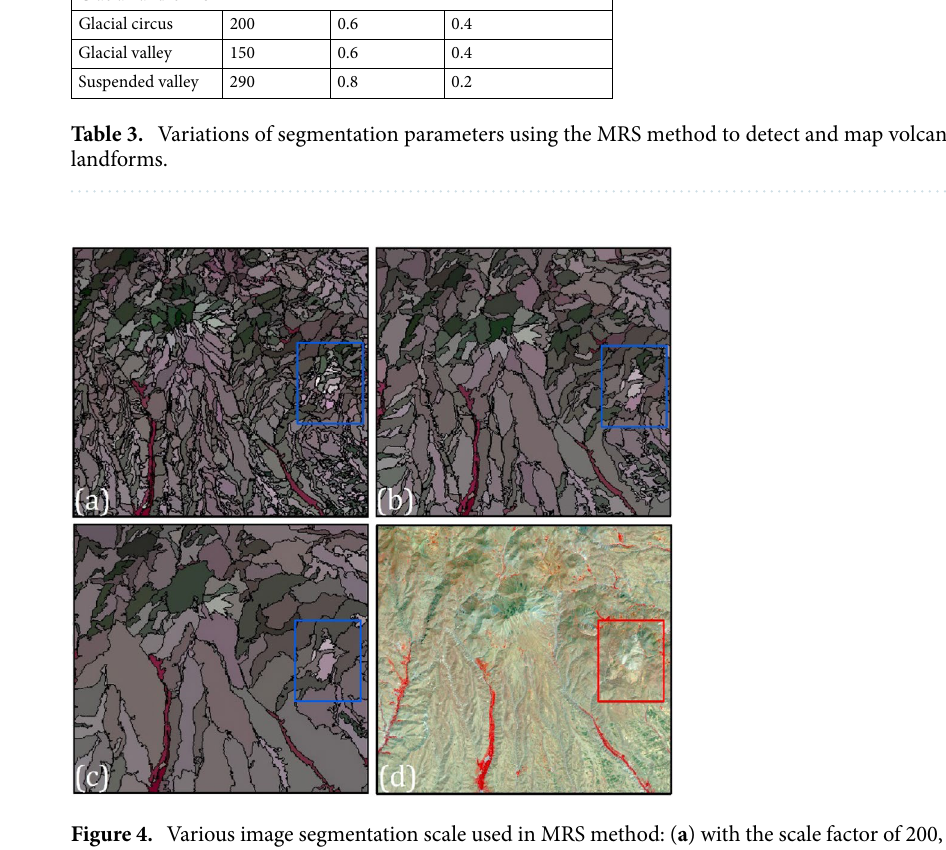
Figure 4. Various image segmentation scale used in MRS method: ( a ) with the scale factor of 200, ( b ) with the scale factor of 400, ( c ) with the scale factor of 600, and ( d ) original Sentinel-2 image.